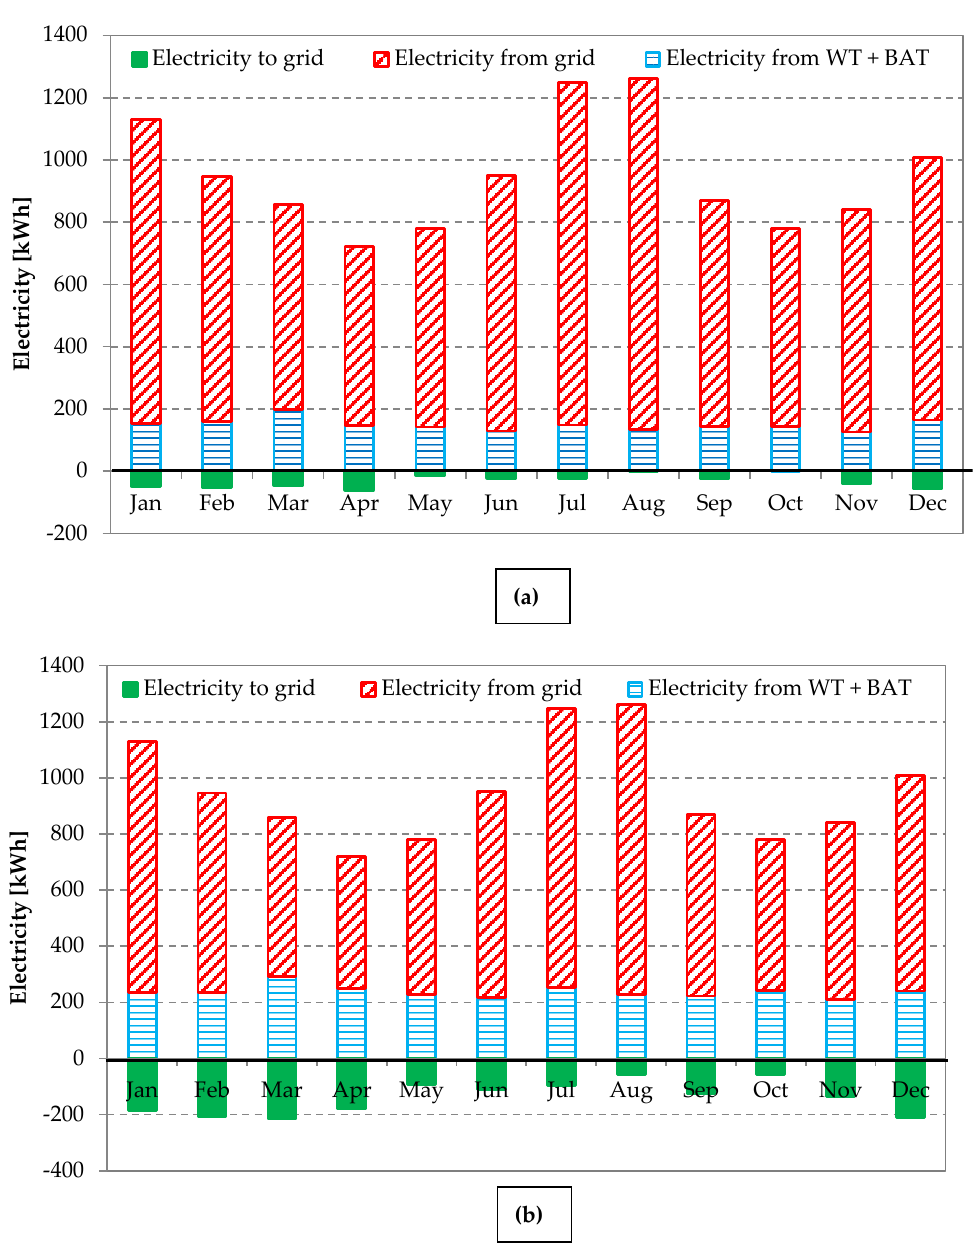
Figure 13. Monthly electricity fluxes for plant configuration: ( a ), 1 HAWT and 9.6 kWh and ( b ) 2 VAWT and 9.6 kWh, in Naples.